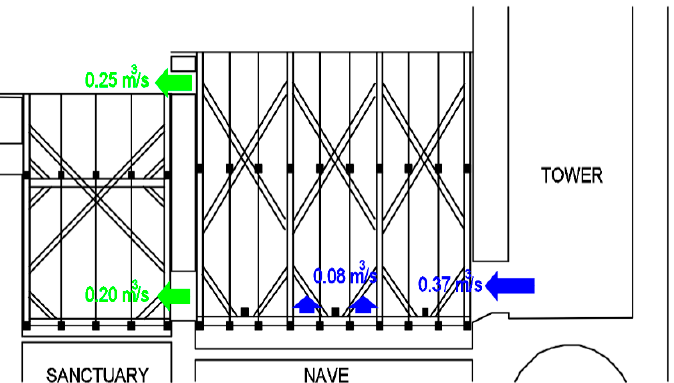
Figure 8. Airflow paths at 12:00 a.m. obtained from BPS simulation in section (blue — inlet, green — outlet). Table 3. Airflow characteristics through the openings at 12:00 a.m. obtained from BPS simulation.